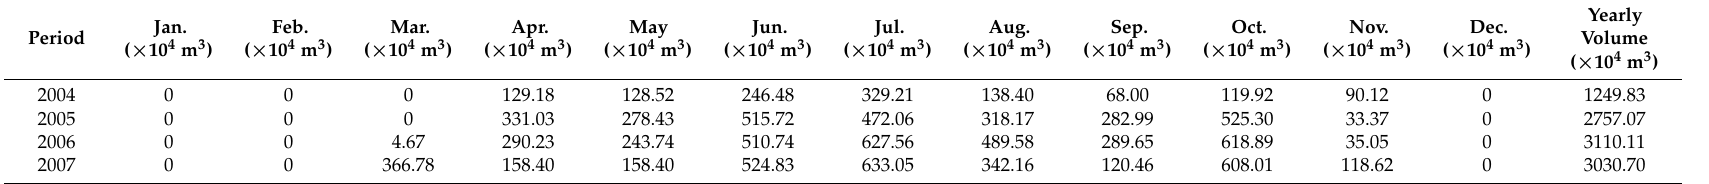
Table 2. Groundwater withdrawals volume in the Seven Stars–Baoerhai water source from 2004 to